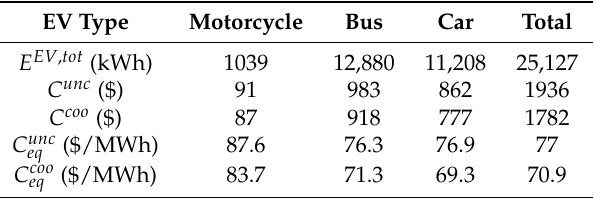
Table 3. Energy and Costs for each type of EV for Scenario